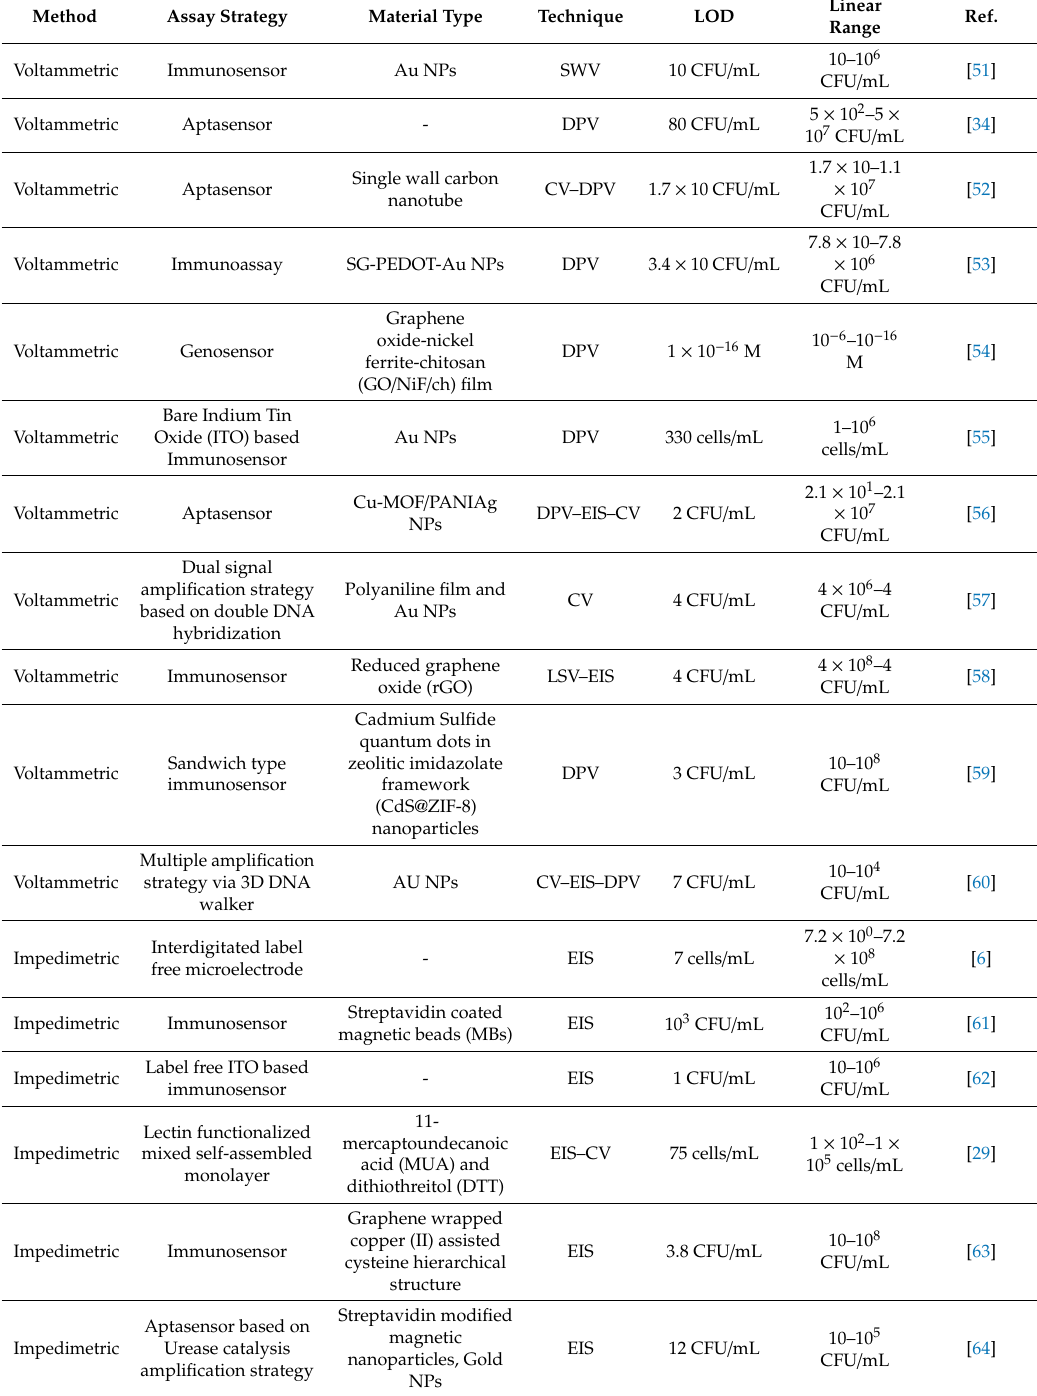
Table 2. Electrochemical sensors for E. coli O157:H7